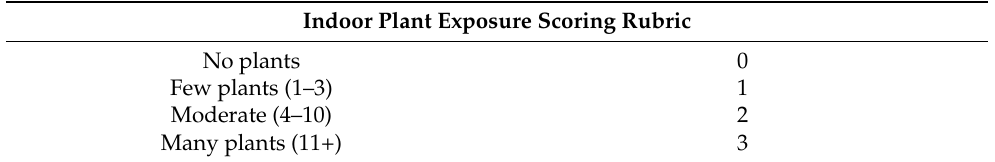
Table A8. Beneficial views of COVID-19 assessment based on survey answers. Participants were told to select all that applied, and scores were cumulative based on their selections. Beneficial Viewpoints of COVID-19 as a Student Scoring Rubric No, this event is stressful on me as a student (See above). 0 Yes, the recent shift to online school has made school easier. 1 Yes, working at home alleviated commutes to campus making life easier. 1 Yes, the shift made my classes less intense. 1 Yes, the shift allowed me to gain more focus at home. 1 Yes, but for reasons not listed. 1 Table A9. Indoor plant exposure assessment for survey answers. Participants were told to select all that applied, and scores were cumulative based on their selections.